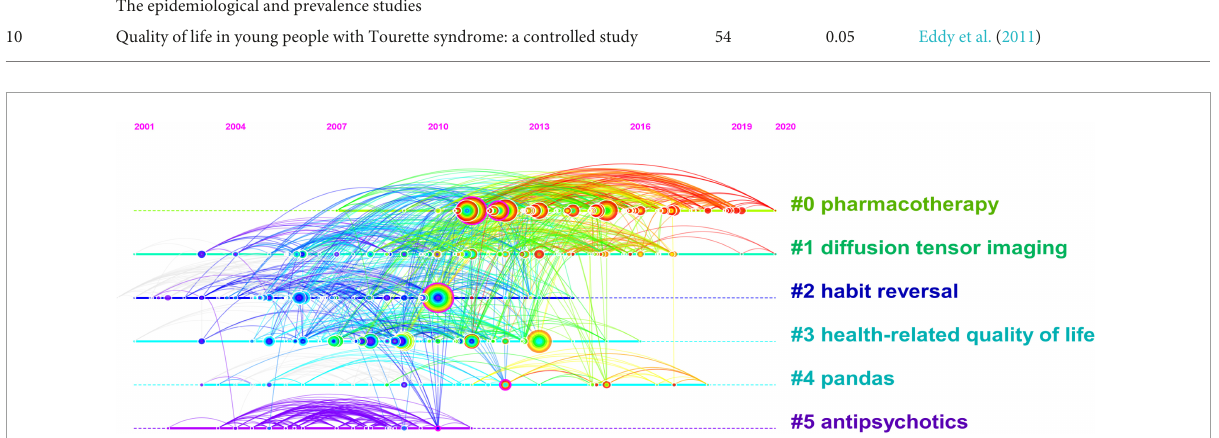
FIGURE5 A reference co-citation map related to Tourette Syndrome (TS) in children research from 2011 to 2021.